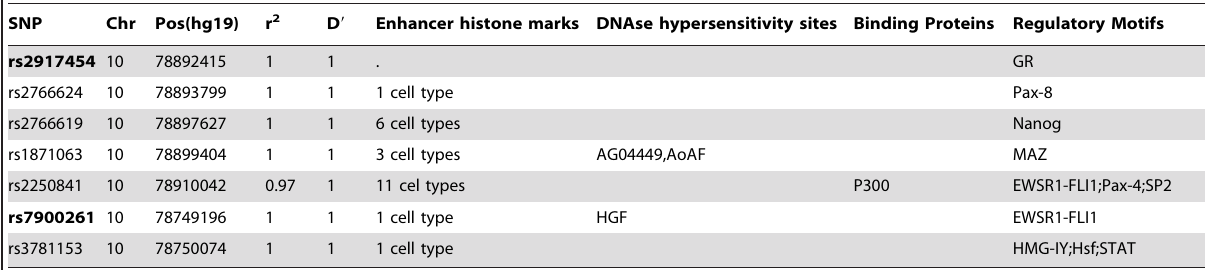
SNP Chr Pos(hg19) r